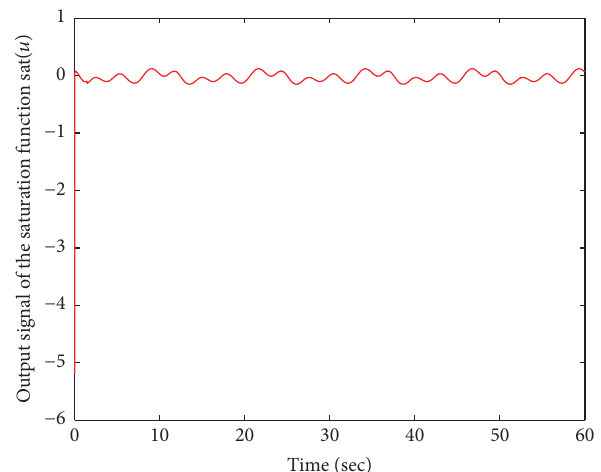
Figure 6: Output respond curve of the saturation function sat (𝑢) .